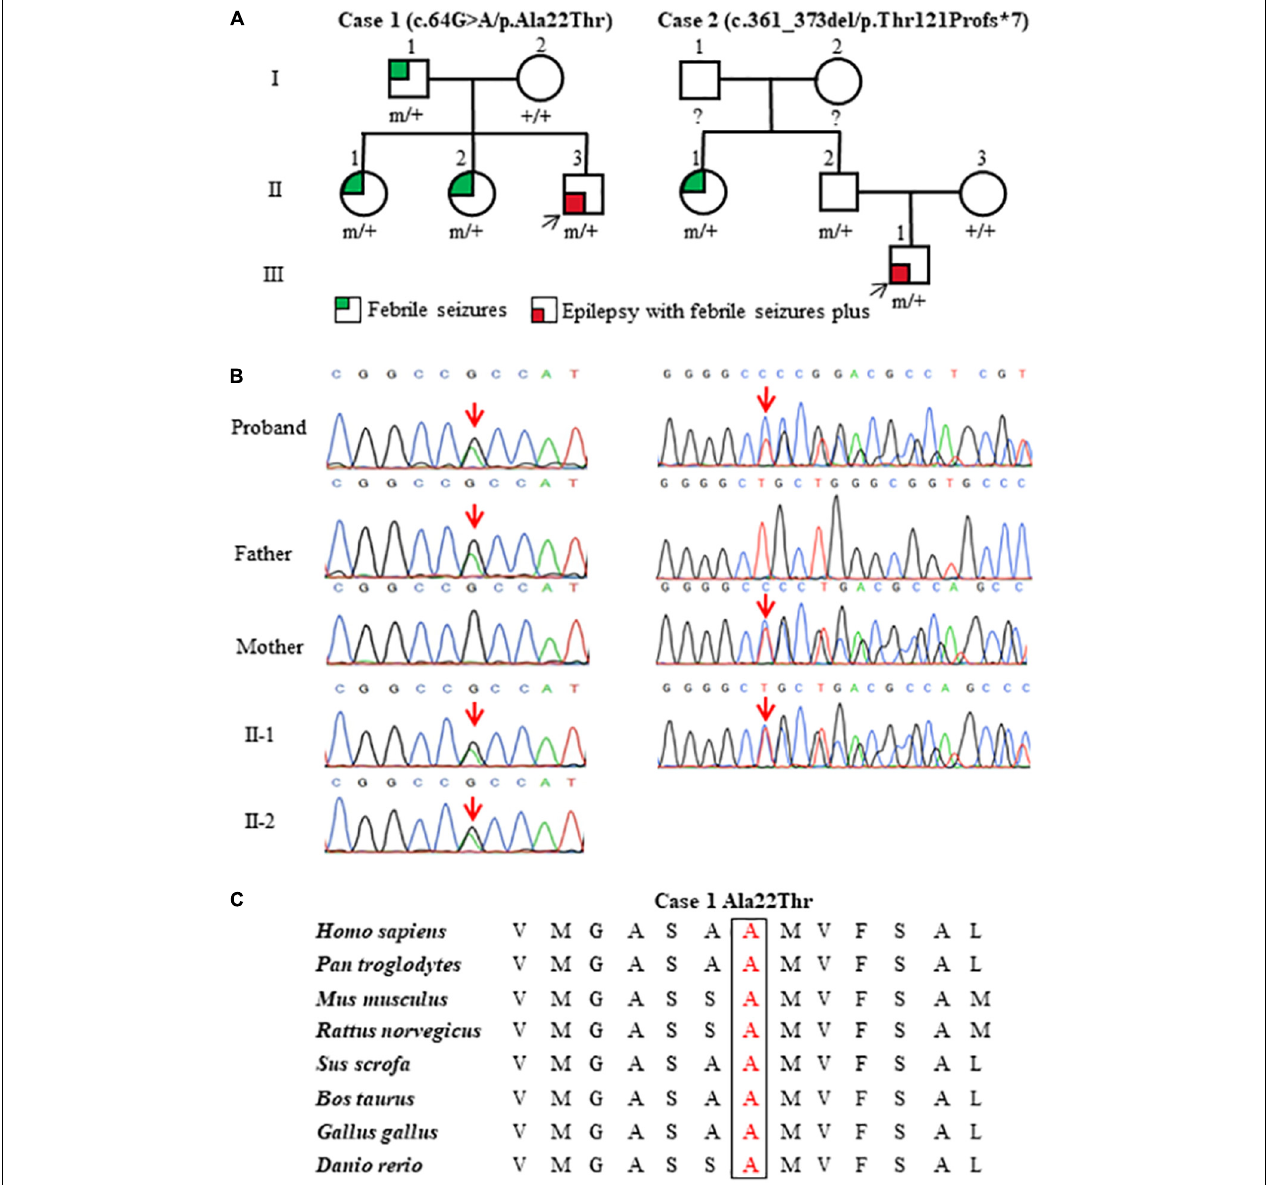
FIGURE 1 | Genetic data of cases with ATP6V0C mutations. (A) Pedigrees of the two families with ATP6V0C mutations and their corresponding phenotypes. Individuals with mutation are marked as m/+, and those without mutation are marked as +/+. (B) DNA sequencing chromatograms of the two families with ATP6V0C mutations. Red arrows indicate the positions of the mutations. (C) Amino acid sequence alignment of the missense mutation shows that residue Ala22 is highly conserved in various